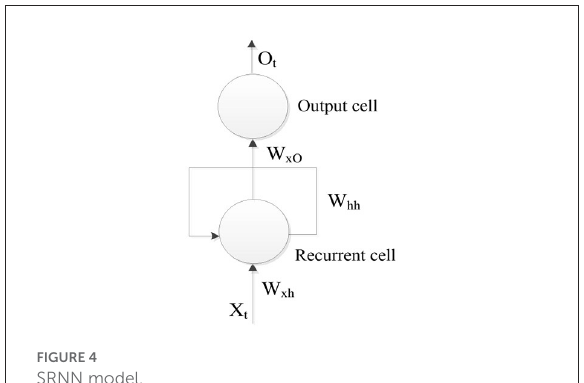
FIGURE4 SRNN model.